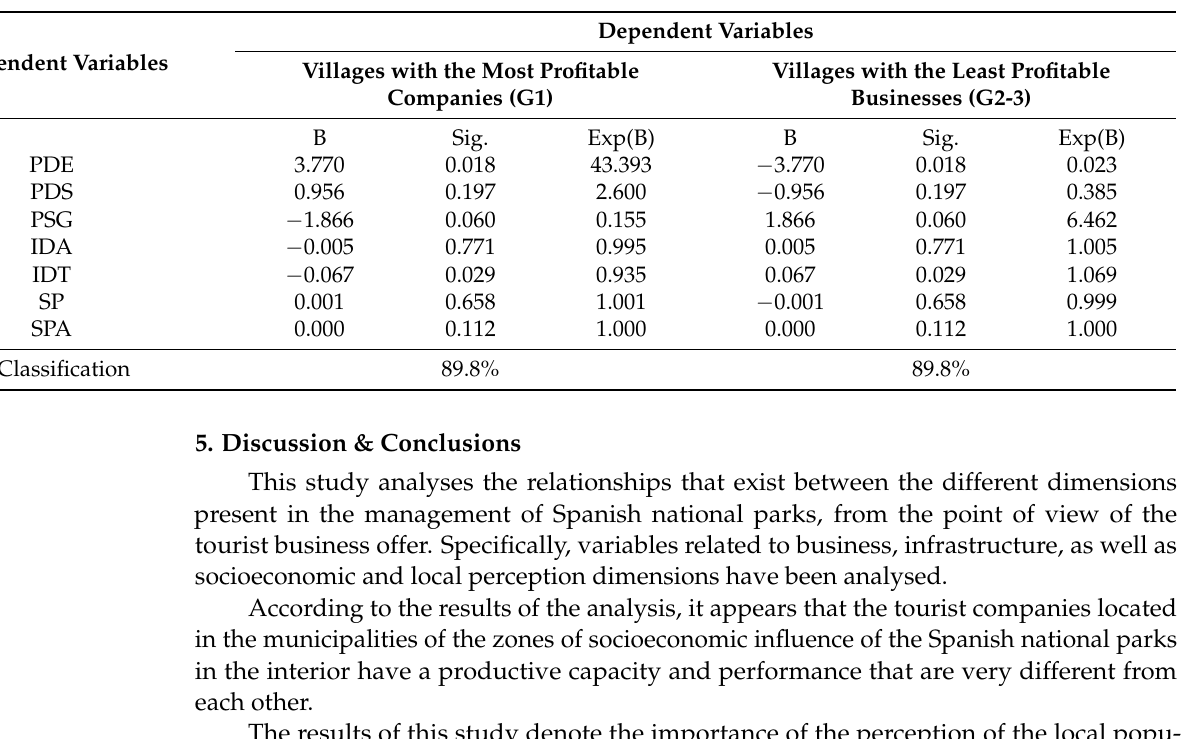
Table 8. Summary of binary logistic regression